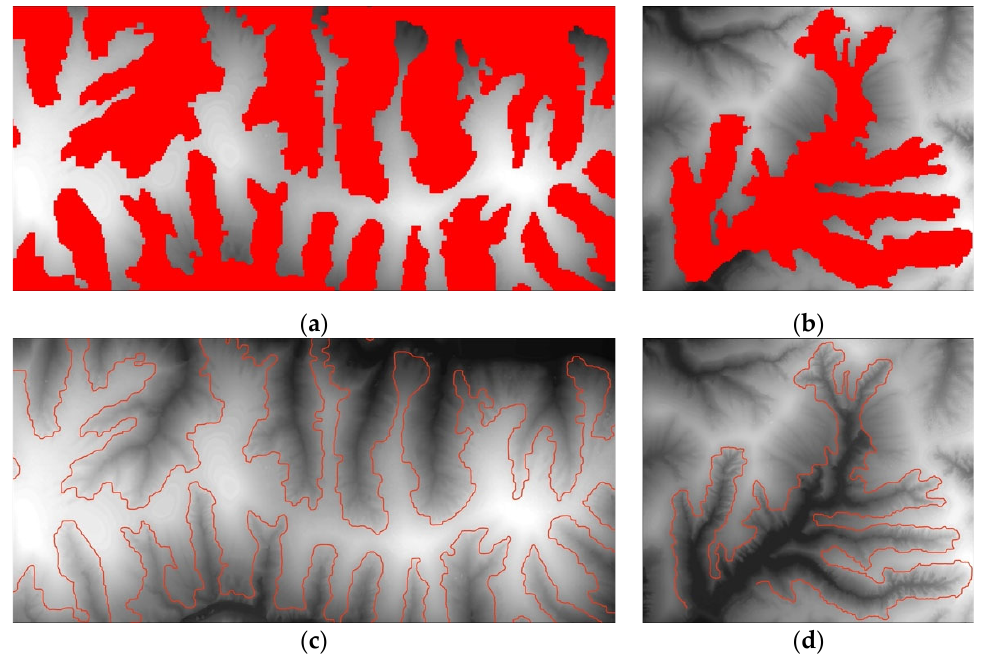
Figure 12. Extraction process of the two test sites. ( a ) Region fusion result of Yan’an area; ( b ) region fusion result of Suide area; ( c ) shoulder-line of Yan’an area; ( d ) shoulder-line of Suide area.